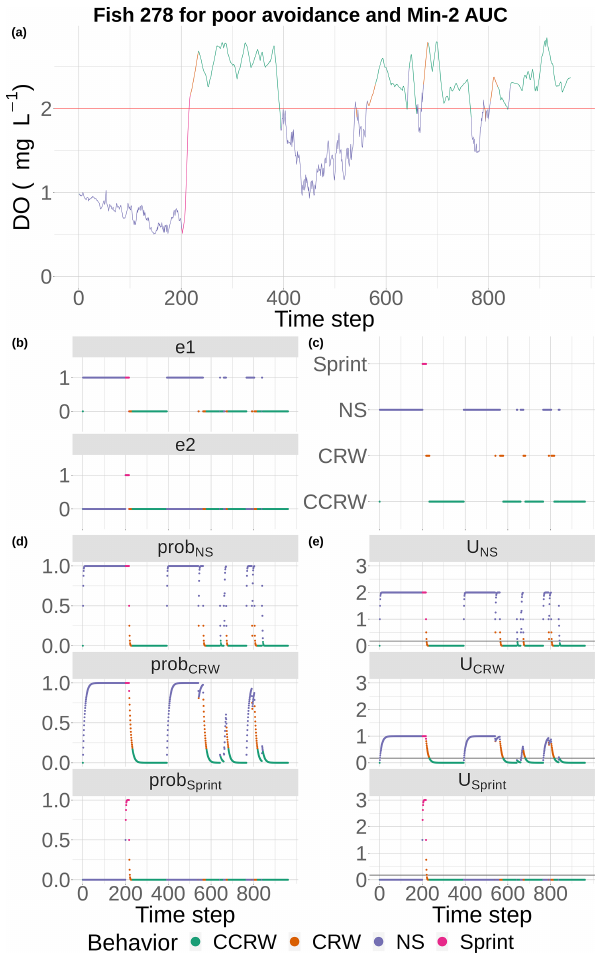
Figure 5. DO experienced and the component calculations used by the event-based algorithm to select movement algorithms at every 15min time step for fish 278 under the conditions of poor compe- tency and minimum AUC (Min-2) maps with moderate sublethal area. DO is used each time step (a) to determine e1 and e2 (b) , with e1 used to compute the probabilities for NS (tactical) and CRW (strategic) avoidance and e2 used to compute the probability for Sprint (d) . These probabilities are used to compute utilities for the three algorithms each time step, (e) and the algorithm with highest utility above a minimum threshold is selected to be used for move- ment for that time step (c) . If none of the three avoidance-related algorithms are selected, then a fourth algorithm (CCRW) that is un- related to DO concentration is